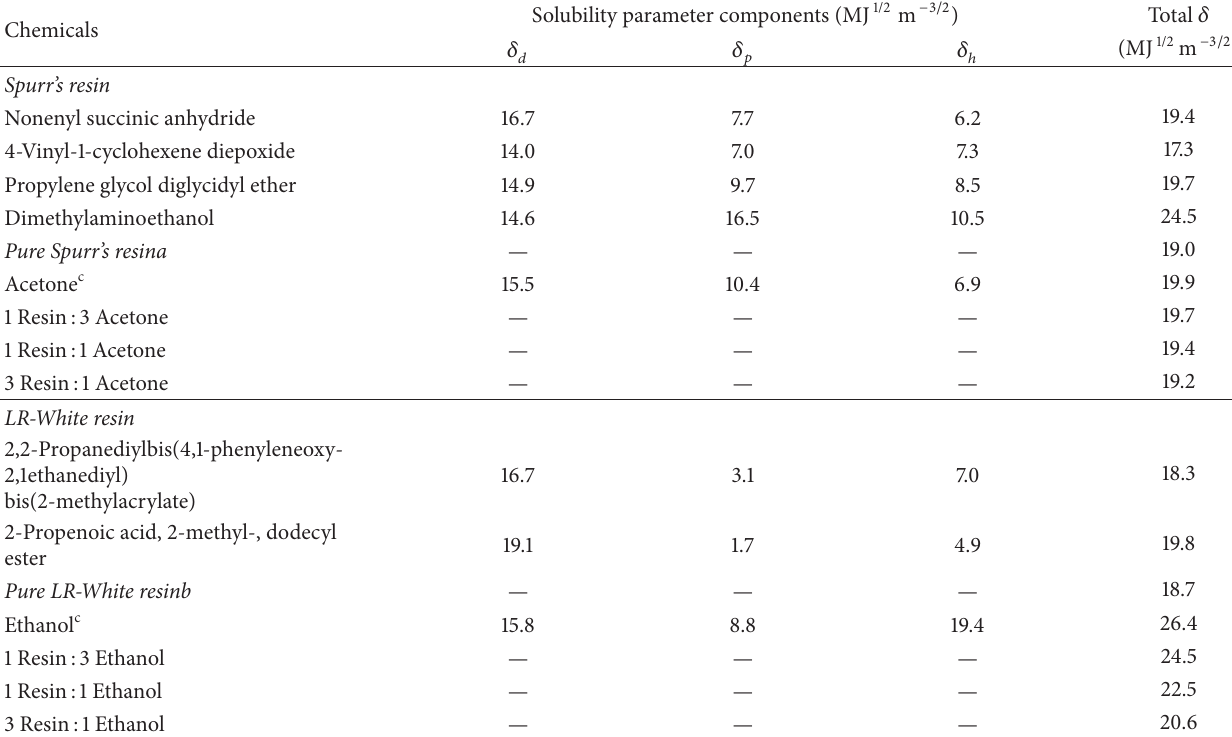
Table 1: Total solubility parameter ( 𝛿 ) and solubility parameter components ( 𝛿 𝑑 , 𝛿 𝑝 , 𝛿 ℎ ) of Spurr’s and LR-White resin chemical components.